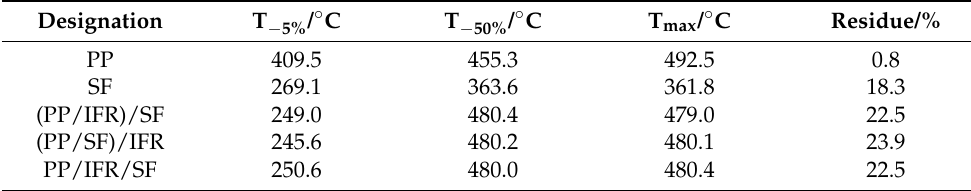
Table 3. Thermal analysis data of PP/SF flame-retardant